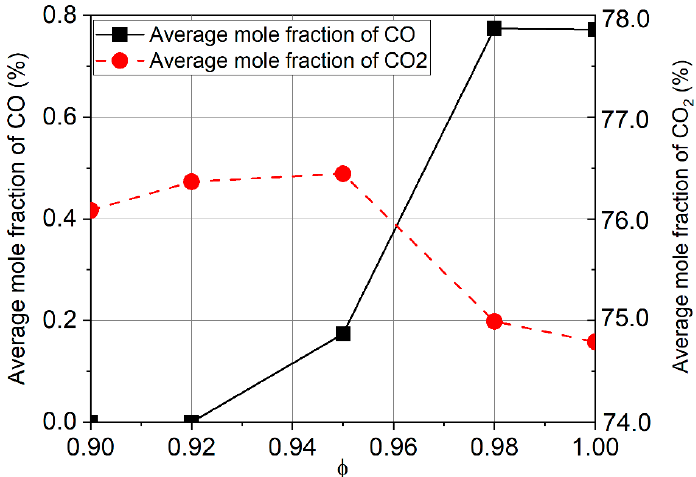
Figure 18. CO and CO 2 emissions for various equivalence factors [41].